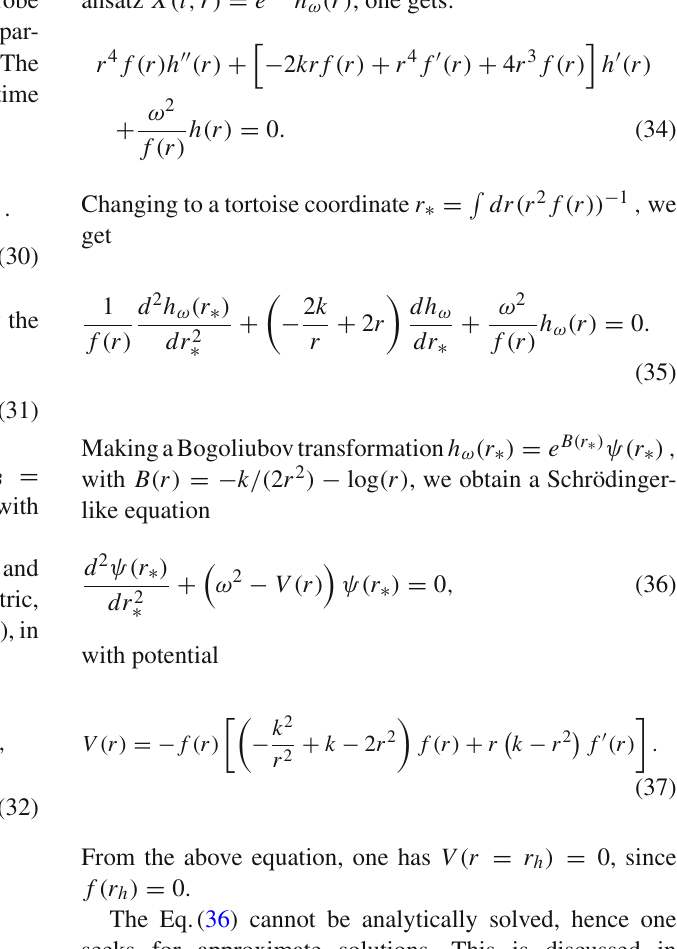
for a fixed k = 1 and some for a fixed k = − 1 and some values panel: temperature versus r − 1 h h of μ . The critical chemical potential is μ c = 0 . 34. For μ > μ c the temperature only